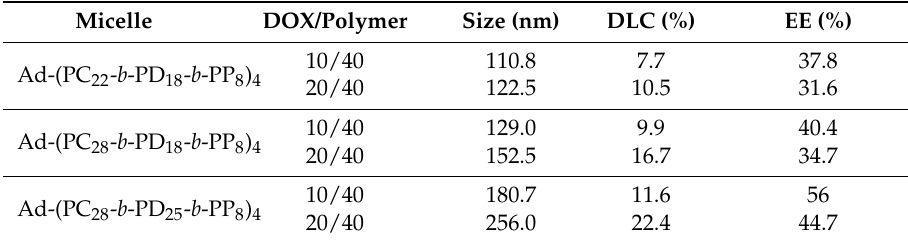
Table 2. Particle size, drug loading content (DLC) and entrapment efficiency (EE) of DOX-loaded Ad-(PCL- b -PDEAEMA- b -PPEGMA) 4 micelles.